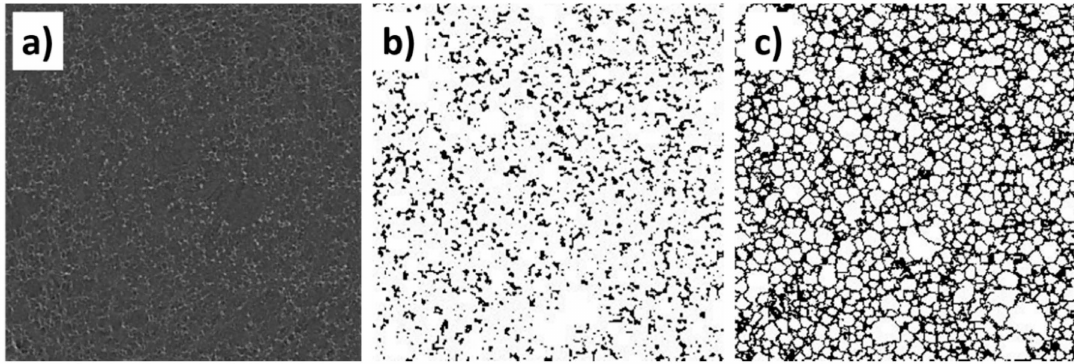
Figure 1. Microtomography (microCT) scan postprocessing: ( a ) reconstructed scan, ( b ) scan after threshold and ( c ) image after anisotropic di ff